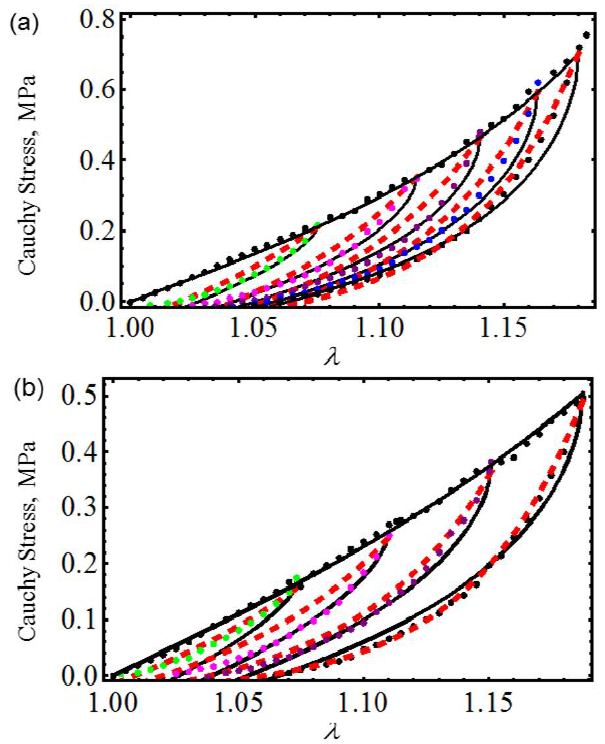
Figure 3. Cauchy stress-stretch data for mice skin compared with the theoretical predictions.